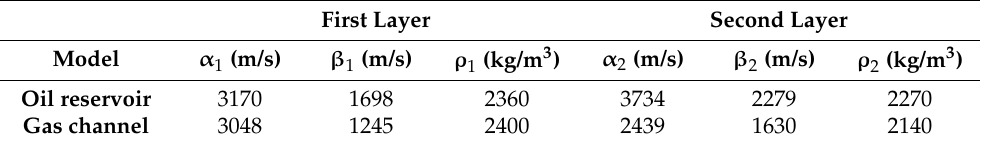
Table 2. VSP survey parameter simulation with the CTP configuration for the TAVO study.